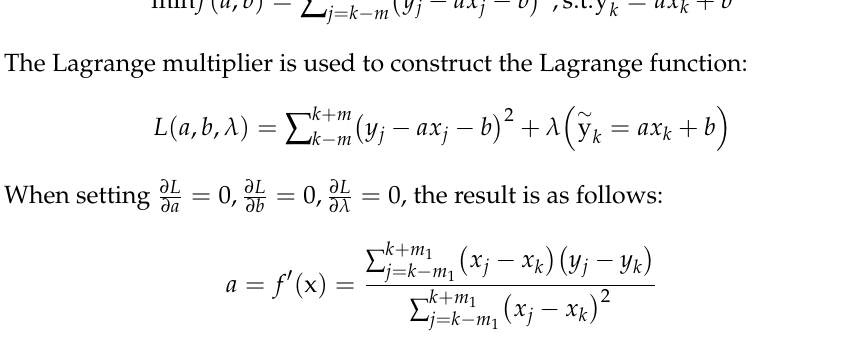
Algorithm 1. U-chord curvature method of discrete curve.